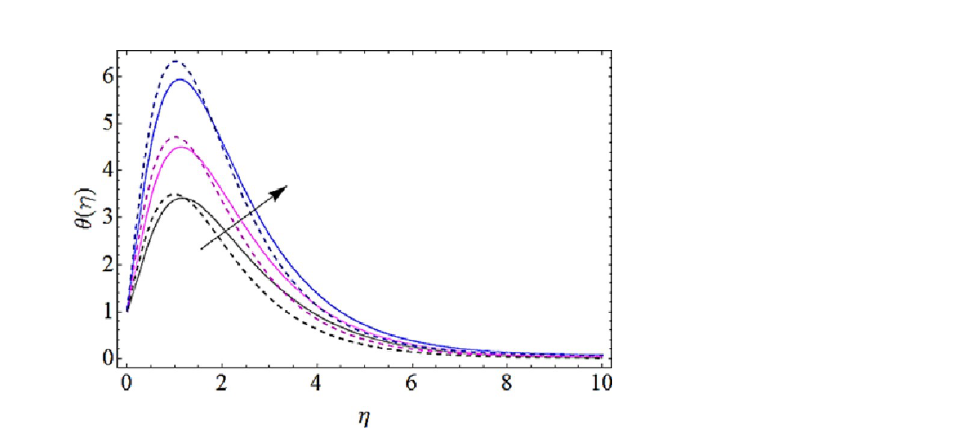
Fig 5. Thermal characteristics for different values of Eckert number.